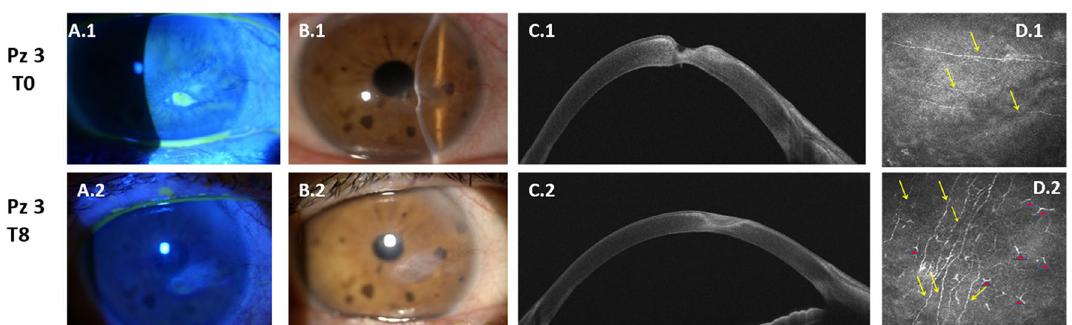
Figure 6. Representative case of severe NK before and after treatment. Patient with an evident corneal ulcer, evaluated by slit lamp examination and fluorescein staining ( A1 – B1 ). Anterior segment OCT shows an important stromal thinning ( C1 ) and in vivo confocal microscopy analysis (IVCM) ( D1 ) evidences a reduced sub-basal nerve fiber density. After 8 weeks of treatment with topical rhNGF , the resolution of the epithelial defect was evident at slit lamp examination and fluoresce in staining ( A2 – B2 ), the healing of stromal ulceration was evident at Anterior segment OCT ( C2 ) and IVCM shows an evident increase of subepithelial nerve fiber density together with Dendritic Cells (DCs) at the level of basal epithelium ( D2 ). Yellow arrows show nerve fibers, while red triangles show